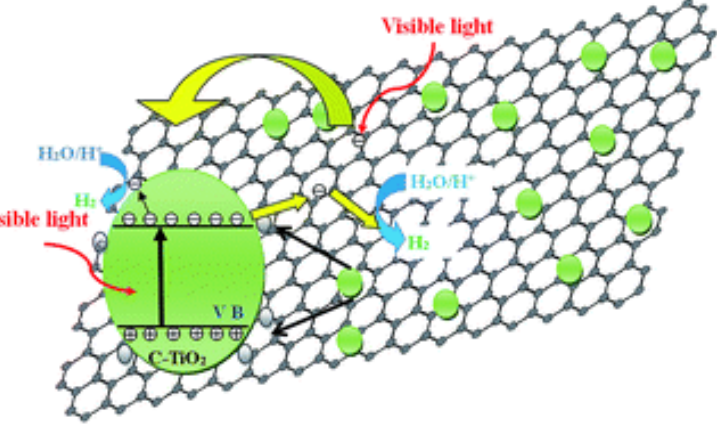
Figure 5. Photocatalytic mechanism of C-TiO 2 /rGO adopted from